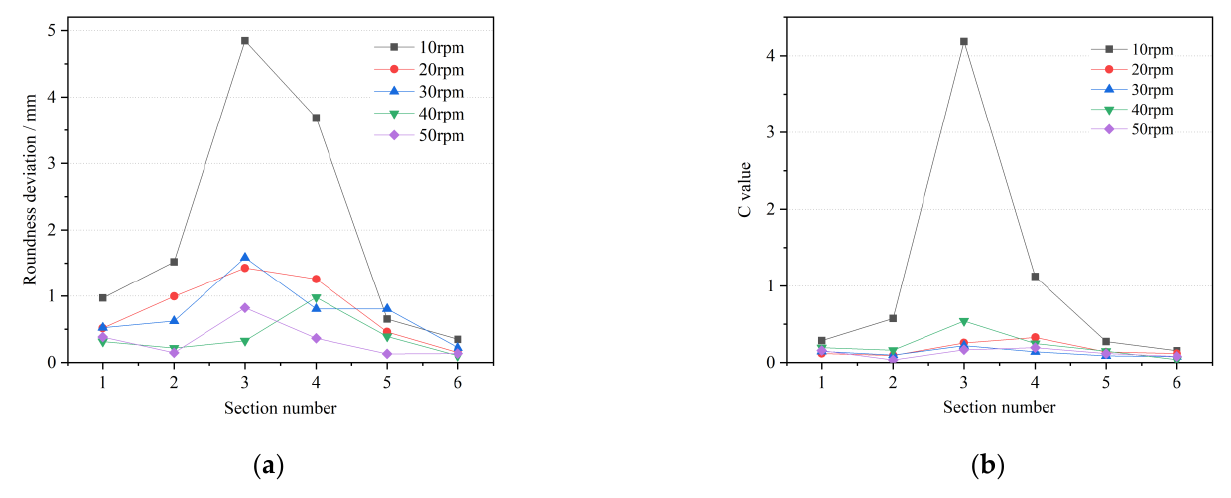
Figure 9. Forming quality under different roll rotational speeds ( a ) roundness deviation; ( b ) wall thickness uniformity.